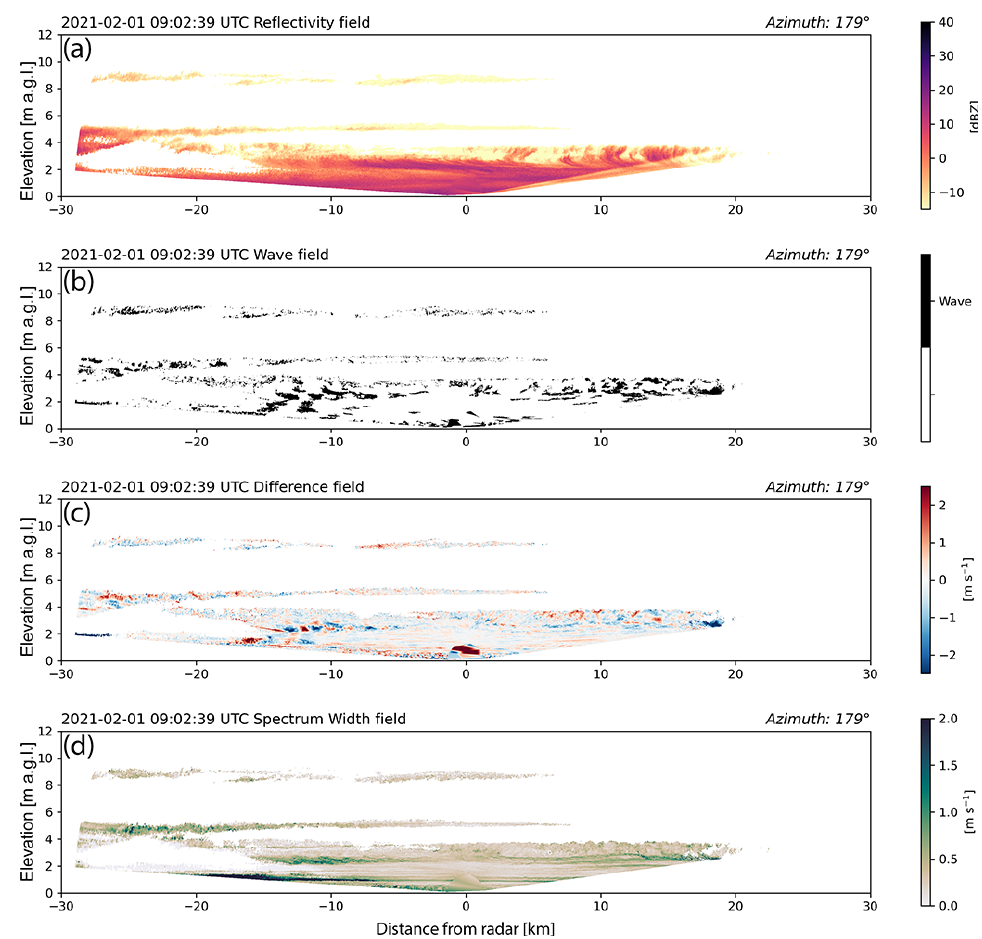
Figure 6. Scanned RHI observed by KASPR radar at Stony Brook University on 1 February 2021 at 09:02:39UTC along the red lines in Fig. 5. RHIs extend from 179 ◦ (south) on the left to 359 ◦ (north) azimuth on the right. (a) Reflectivity, (b) binary wave detection, (c) difference between the KASPR radar’s dealiased radial velocity fields at 09:02:00 and 09:00:41UTC, and (d) spectrum width field at 09:02UTC. Images plotted using a 1:1 aspect ratio. An animated version of this figure is in Video Supplement